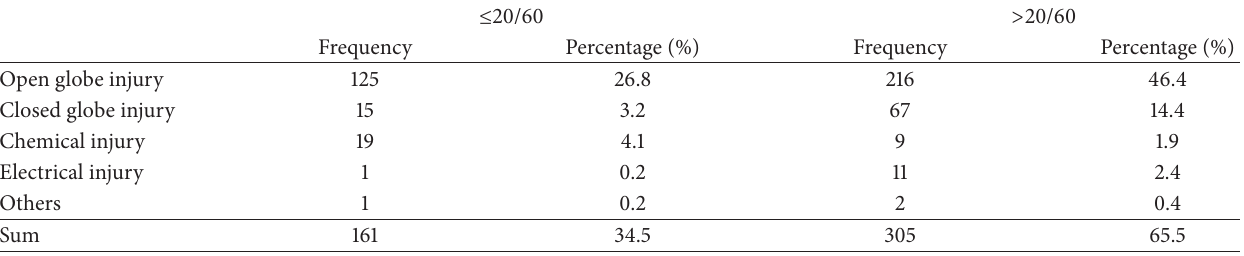
Table 3: The final VA of different types of injuries.